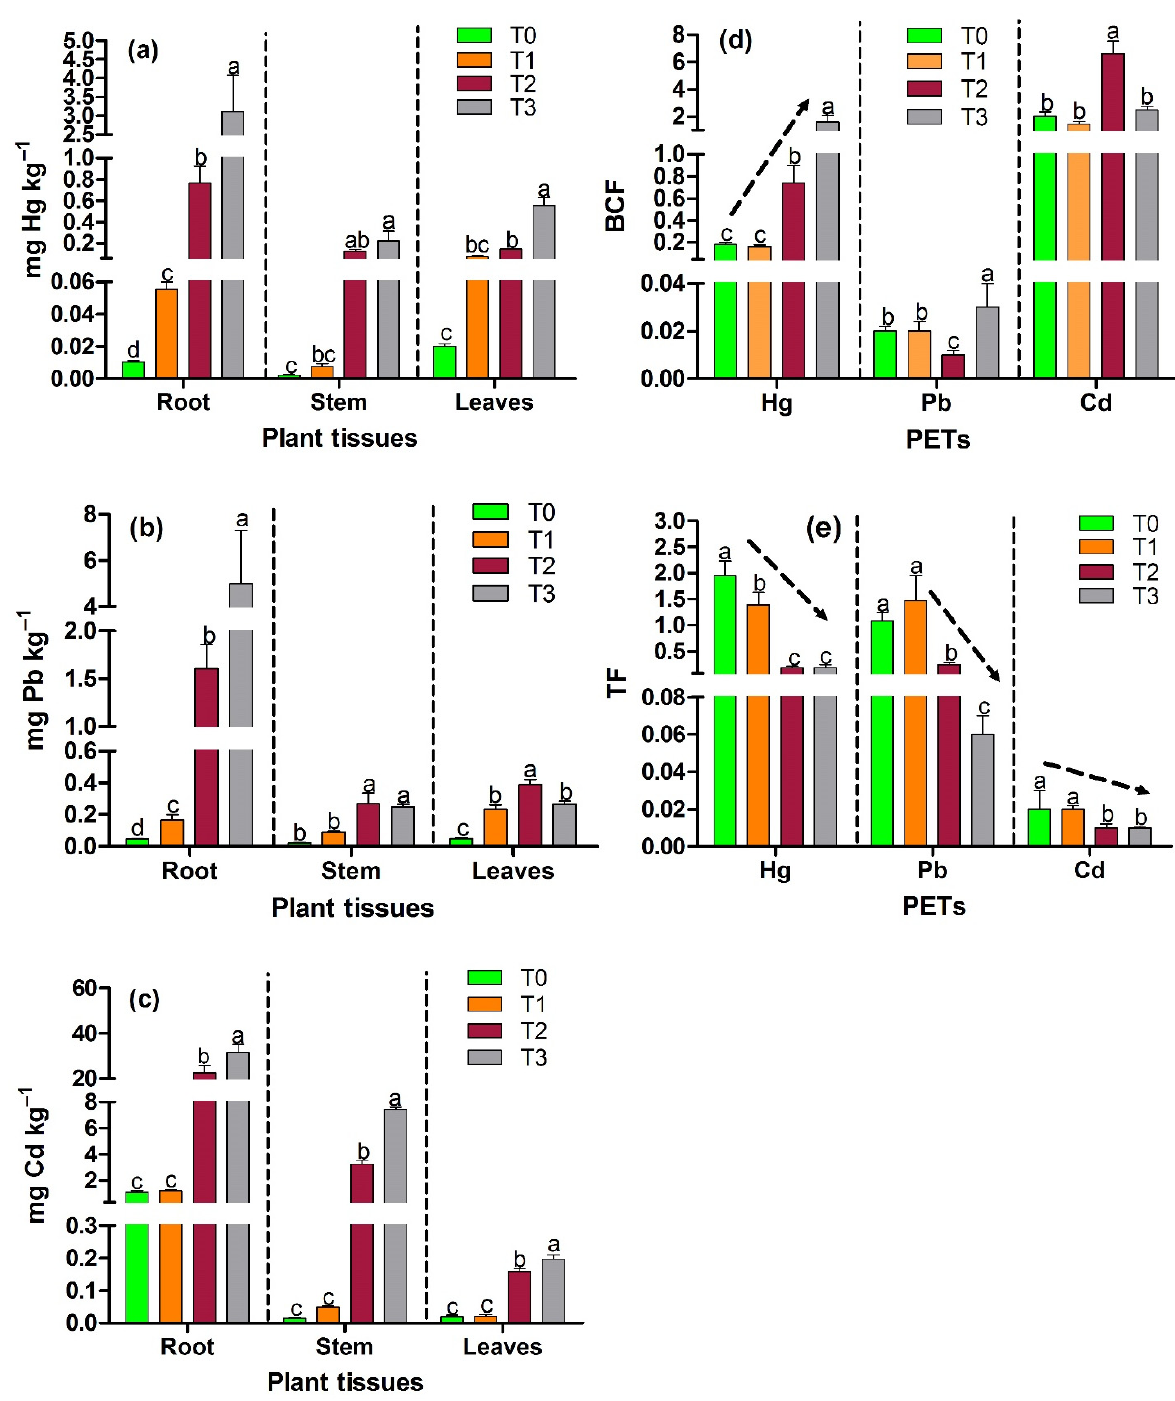
Figure 2. Concentration of PTEs in plant tissue and phytoremediation indices ( a ) Hg. ( b ) Pb. ( c ) Cd. ( d ) BCF. ( e ) TF. Different letters indicate significant statistical differences ( p < 0.05) using Tukey’s test between each treatment per tissue.